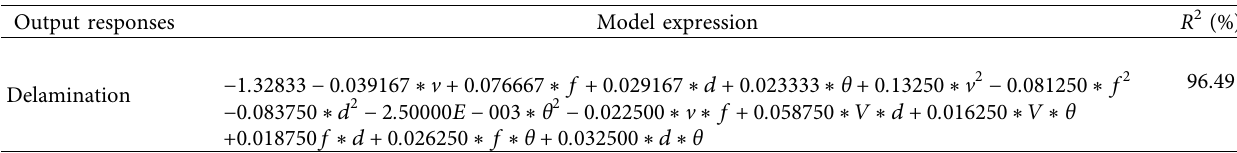
Figure 2: (a) Correlation graph; (b) 3-D response graphs for delamination. Table 6: . Model summary for carbide multifaceted